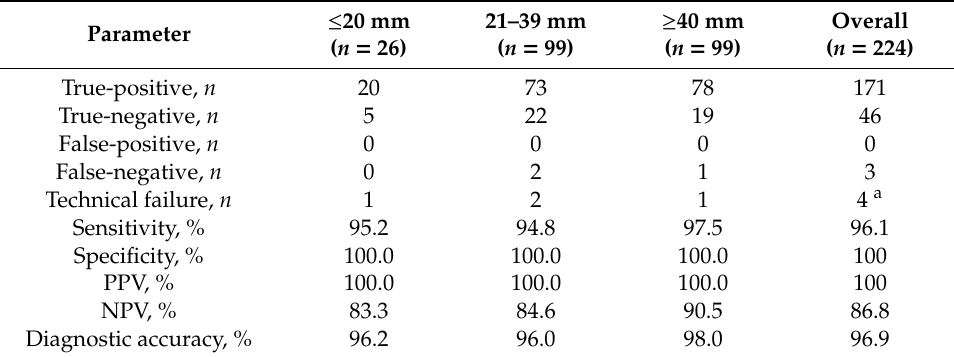
Table 3. Diagnostic yield of CT-guided PTNB ( n =